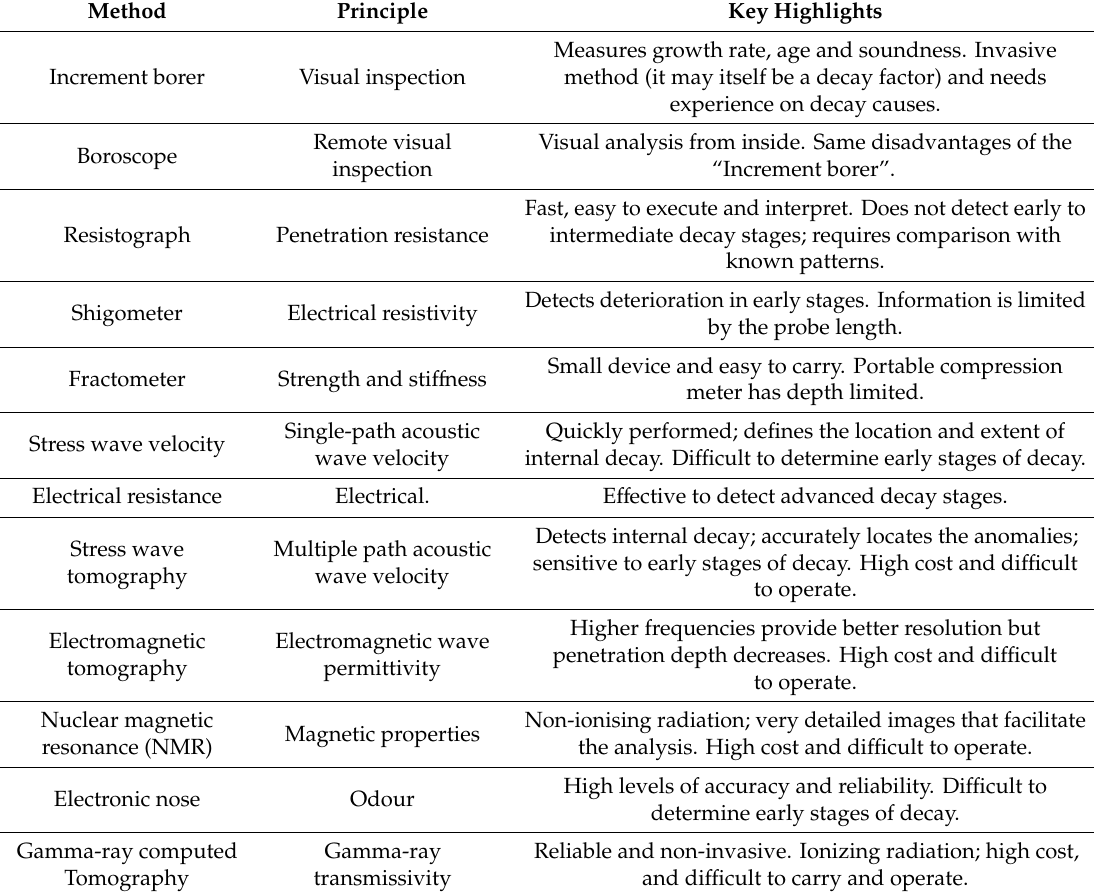
Table 1. A brief summary of the other main methods for detecting tree deterioration (adapted from